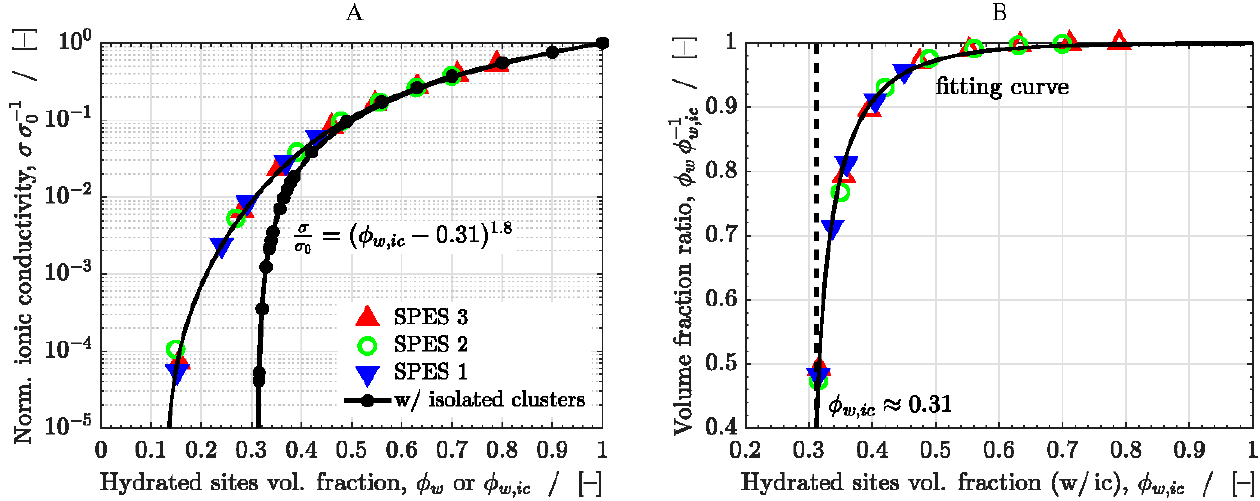
Figure 5. ( A ) Normalized ionic conductivity, σ / σ o , as a function of the volume fraction of hydrated, conductive sites, φ w = DS φ wr , corresponding to the network without and with isolated water clusters (colored and black symbols, respectively). ( B ) Ratio between the volume fraction of hydrated, conductive sites of both networks, φ w / φ w , ic , as a function of φ w , ic . The results of the network without isolated clusters are presented for the three SPES membranes. The fitting curves to the data are included in all cases.